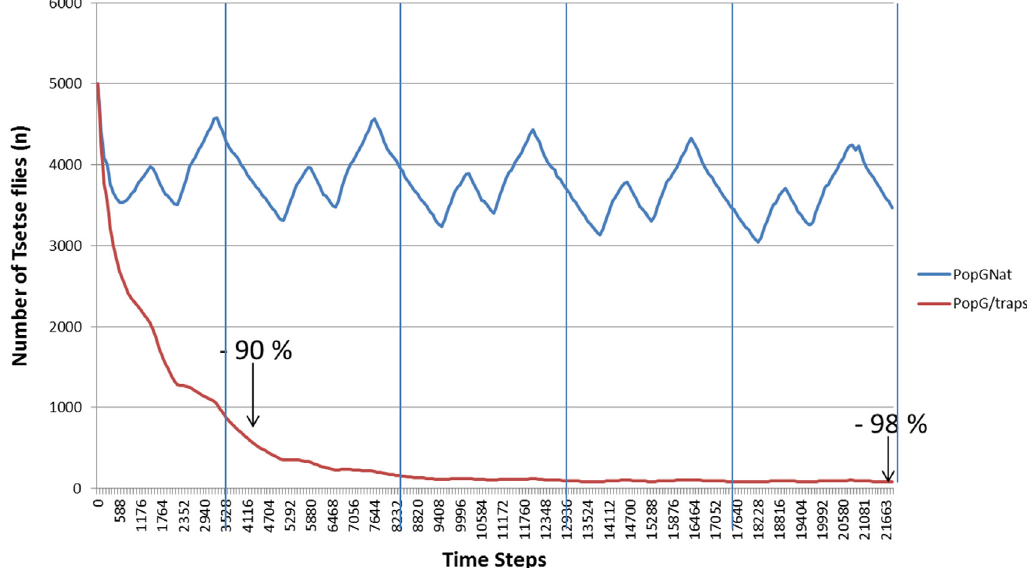
Figure 5. Comparison, over 5 years, of the evolution of the natural tsetse flies population (PopGNat) with a vector control device (PopG/traps).